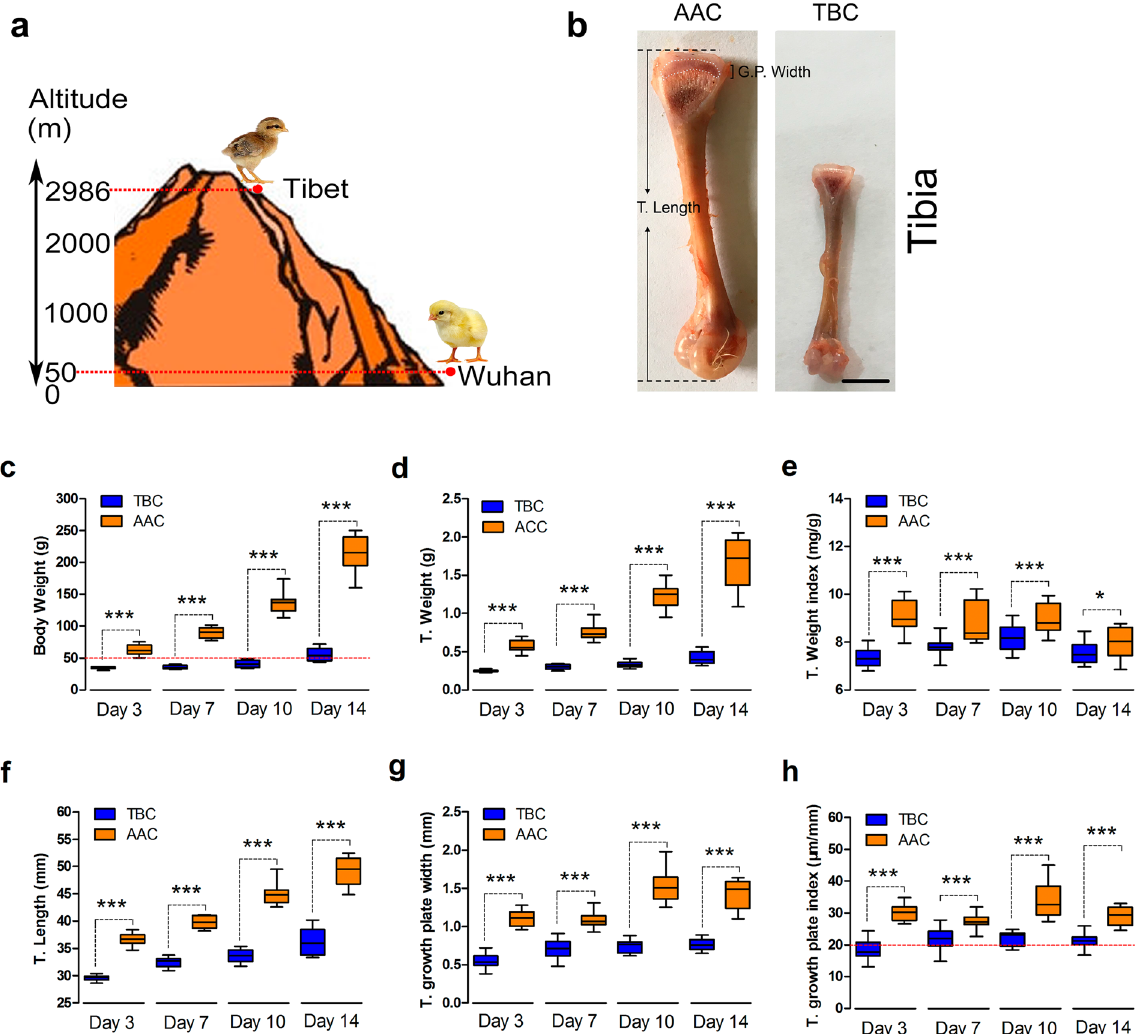
Figure 1. Tibetan chickens and their tibiae grow slowly compared to AA chickens. ( a ) Feeding location (experimental site) of the TBCs (2,986 meters above sea level; Tibet, China) and AA chickens (50 meters above sea level; Wuhan, China). ( b ) Standard for measurement of the T. Length (tibia length) and T. G. P. Width (tibial growth plate width). ( c , d , f , g ) The body weights and tibia weights of the chickens and the lengths and growth plate widths of the tibiae were recorded and compared between the TBCs and AACs. ( e ) The tibial weight index was determined as the tibial weight per corresponding body weight of the chicken (T. Weight/body weight, mg/g) between the TBCs and AACs. ( h ) The tibial growth plate index was determined as the tibial growth plate width per tibia length (T. growth plate width/T. length, µ m/mm) between the TBCs and AACs. Student’s t -test, *** p < 0.001, n = 16; Error bars indicate SD. AAC, Arbor Acres chicken; TBC, Tibetan